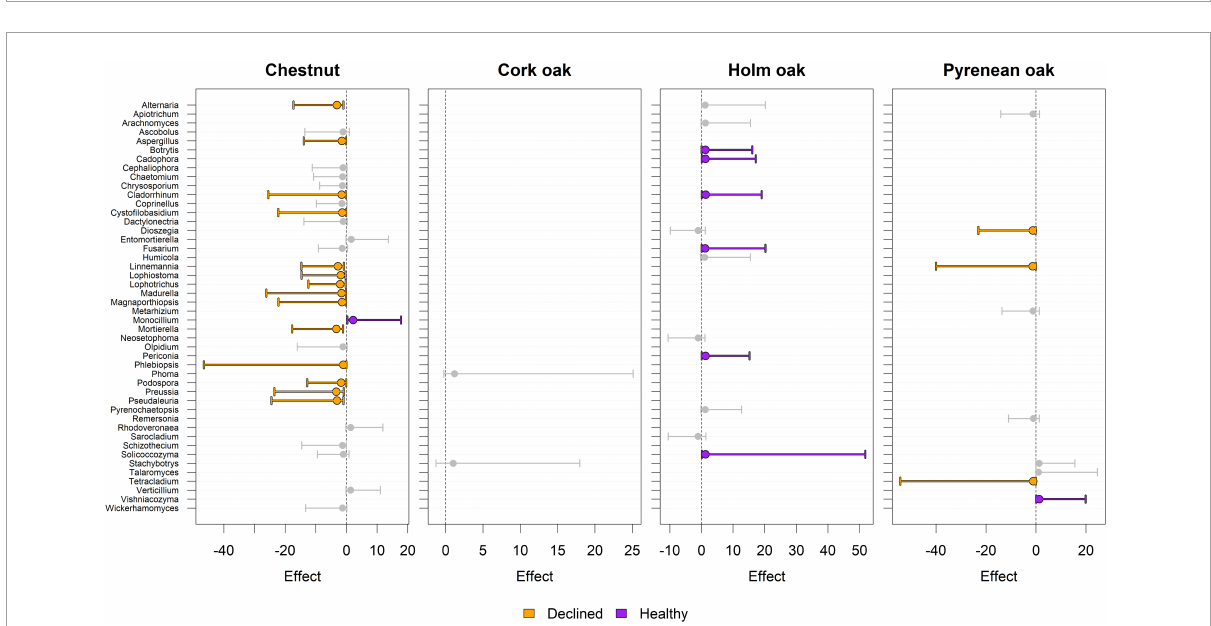
FIGURE7 Differentially abundant (DA) genera detected by ALDEx analysis. Effect size point estimators and 95%CI are shown. Vertical gray lines indicate no effect. Colored dots and intervals indicate differential abundance (zero line not crossed) for a given tree species. Only genera with effect > 1 (absolute value) in at least one tree species are shown to facilitate visual comparisons. Absence of a genus in a plot indicates that its effect was < 1 (absolute value). Positive effect size favors healthy status and vice versa. Size of confidence intervals can be interpreted as a proxy of the effect size estimation robustness (the smaller the